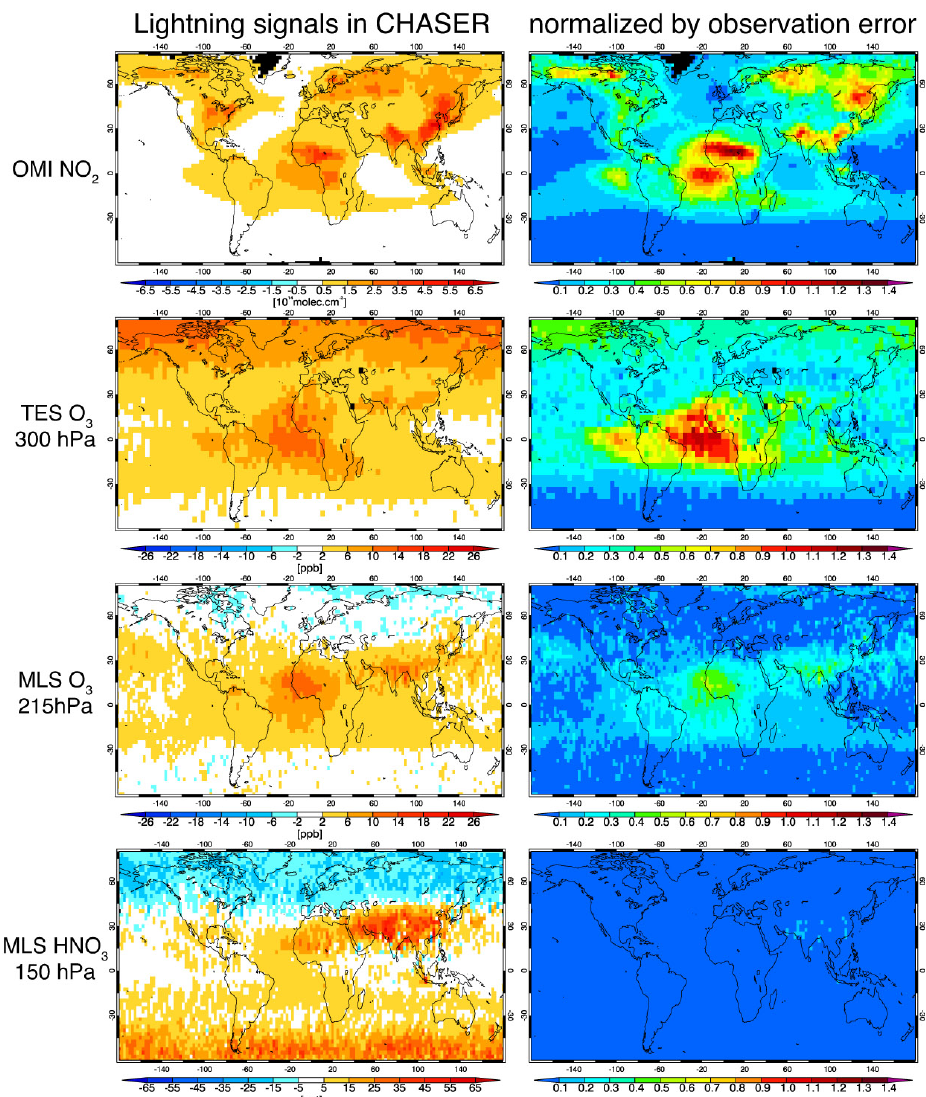
Fig. 4. Global maps (left panels) of the concentration differences between the CHASER simulations with and without lightning sources and (right panels) the mean ratio of the lightning signals to the measurement errors as estimated along each satellite track by applying the averaging kernels of OMI NO 2 (in 10 14 moleccm − 2 ), TES O 3 (ppbv) at 300hPa, MLS O 3 (ppbv) at 215hPa, and MLS HNO 3 (pptv) at 150hPa for June, July, and August in 2007. A super-observation approach is employed to the OMI measurements, whereas individual observations are used in the analysis of the